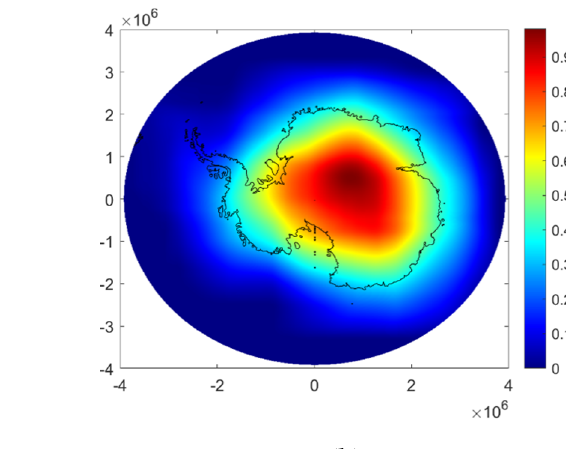
( b ) Figure 4. Skin surface temperature (K) maps from: ( a ) Arctic, October 3; and ( b ) Antarctic, October 9. 2.3. Sea Ice Concentration and Sea Ice Extent Retrieval Using Neural Networks As mentioned in the previous sections, the main purpose of this work is to combine GNSS-R and MWR data from FSSCat by implementing and optimizing NNs to yield ac- curate maps of SIC and the associated with SIE at the polar scale. For both maps, the data from both sensors is combined in a two-step procedure. The first step uses the MWR and the auxiliary data as inputs of a NN to compute whether a pixel is ice or water. For the second step, the GNSS-R data analyzed with the NN supports the MWR data to condi- tionally enhance resolution whenever data at specular points is available. The maps gen- erated in the first step have a spatial resolution of 12.5 km, and over them, the output points of the second step are placed in a non-gridded format in order to improve the res- olution of the GNSS-R data (~250 m). SIC maps are generated following the same two steps of the SIE procedure but using a different NN.